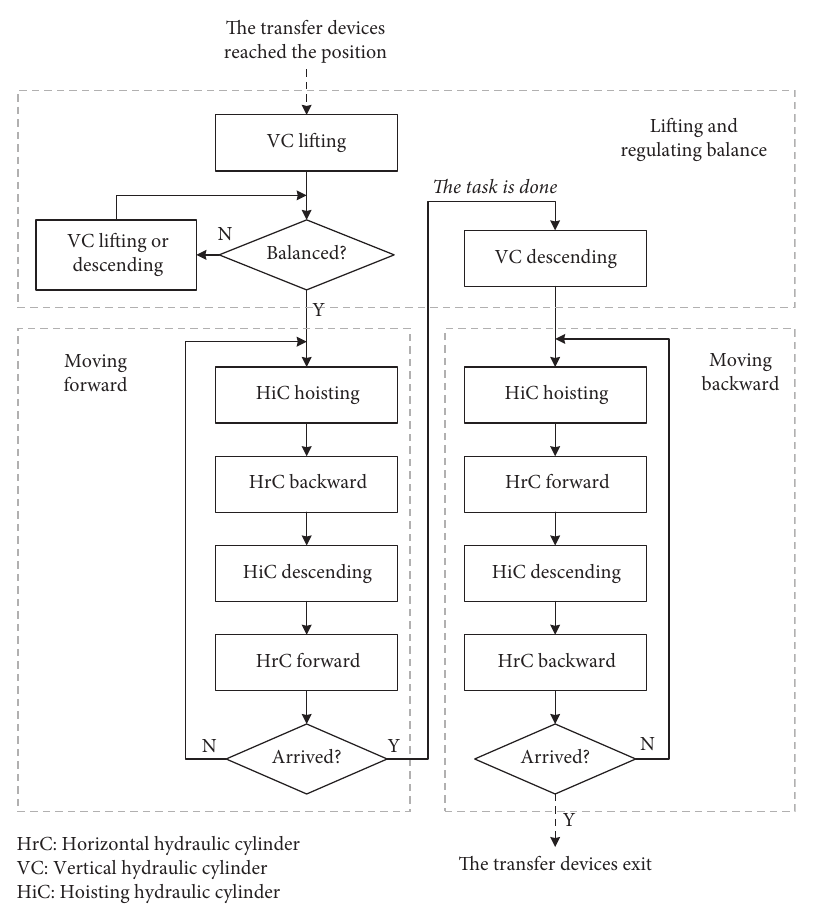
Figure 11: The control logic of the transfer device in automatic mode. Table 3: Some parameters of vertical hydraulic cylinder